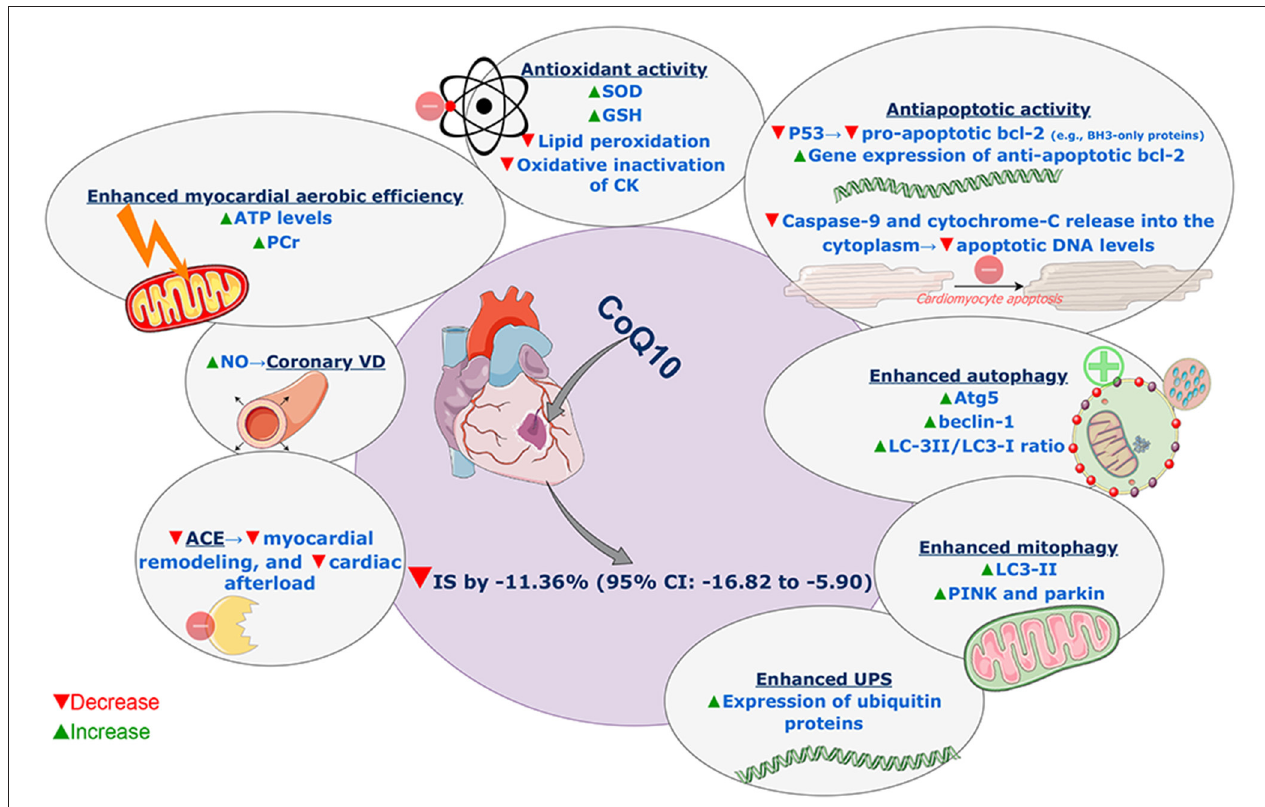
FIGURE 4 | Summary of involved potential mechanisms of action of coenzyme Q 10 reducing effect on myocardial infarct size in models of myocardial ischemia-reperfusion injury. SOD, superoxide dismutase; GSH, glutathione; CK, creatine kinase; UPS, ubiquitin-proteasome system; ACE, angiotensin-converting enzyme; NO, nitric oxide; VD, vasodilatation; ATP, adenosine triphosphate; PCr, phosphocreatine; CoQ 10, coenzyme Q 10 ; IS, infarct size; CI, confidence interval. This figure was produced on diagrams.net, using SMART materials (Servier Medical Art; smart.servier.com) that are approved under a Creative Commons Attribution 3.0 Unported